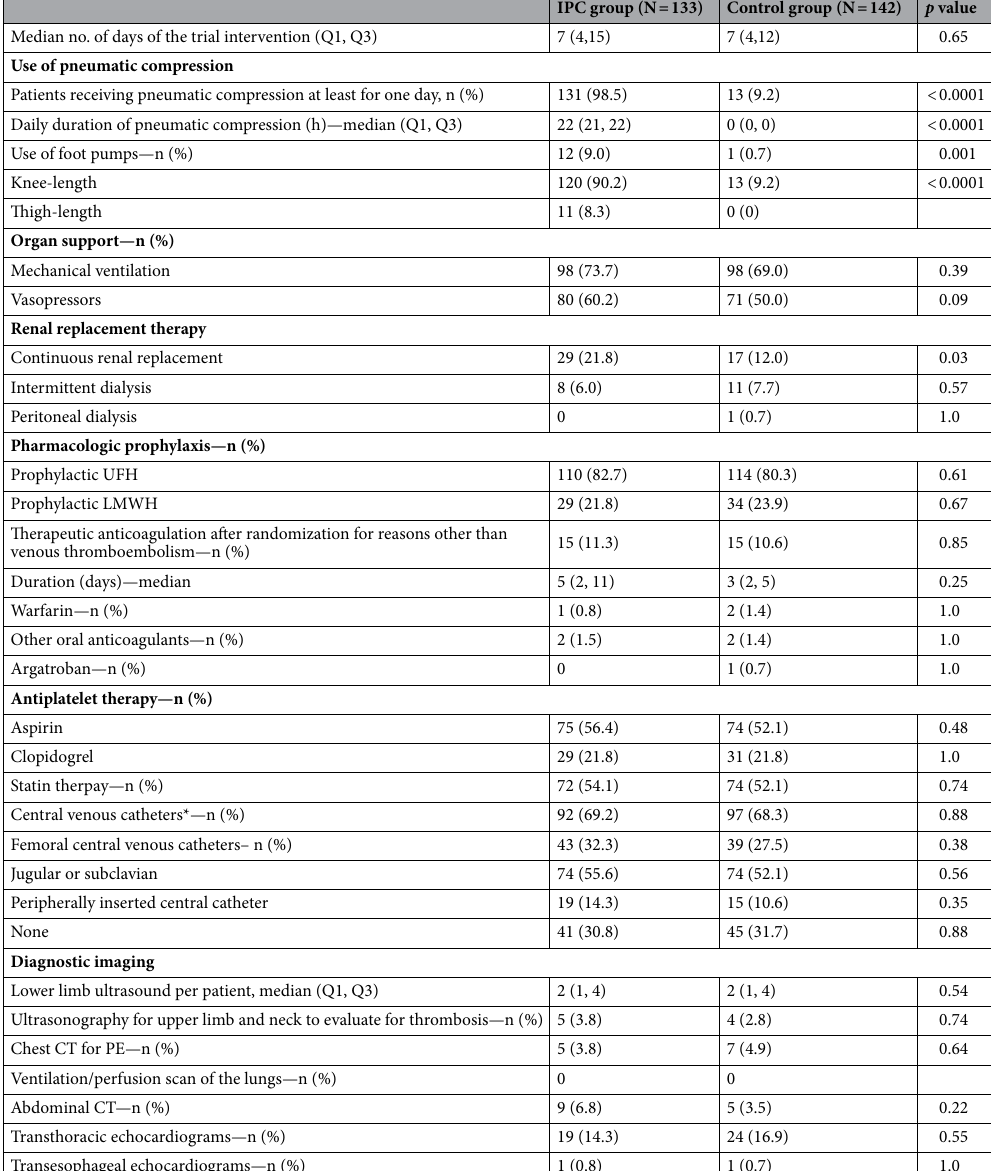
Table 2. ICU interventions and co-interventions in patients with heart failure who were randomized to intermittent pneumatic compression with pharmacologic thromboprophylaxis (IPC group) or pharmacologic thromboprophylaxis alone (control group). CT Computed tomography, IPC Intermittent pneumatic compression, LMWH Low molecular weight heparin, PE Pulmonary embolism, Q1 First quartile, Q3 Third quartile, UFH Unfractionated